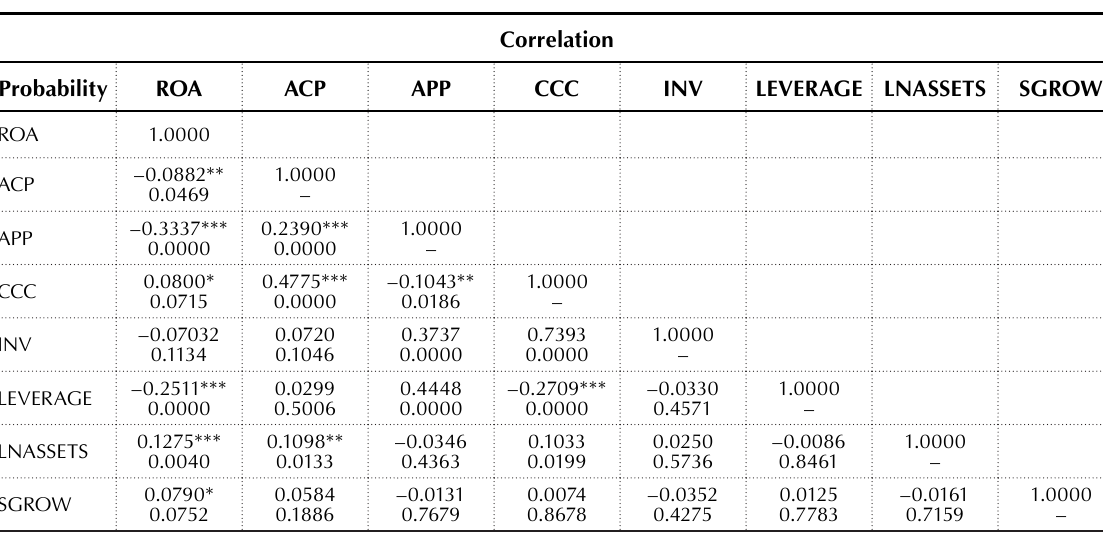
Table 2. Pearson’s correlation